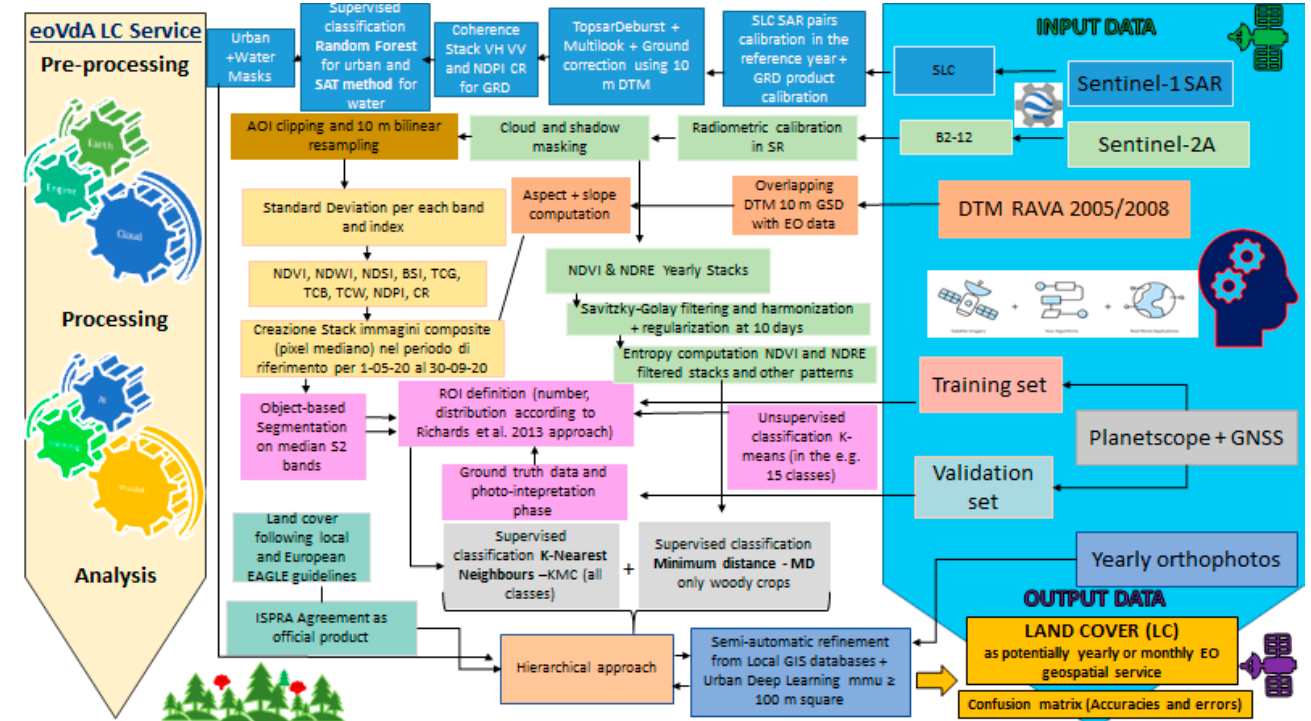
Figure 4. Workflow processing to process the scalable Earth Observation service to map land cover in geomorphological complex areas.